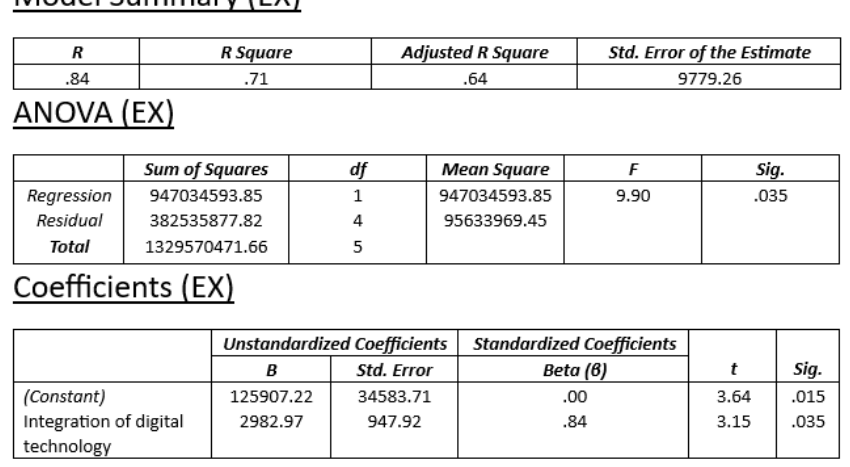
Figure 14. Linear regression: digitalization and exports—an average of EU states.